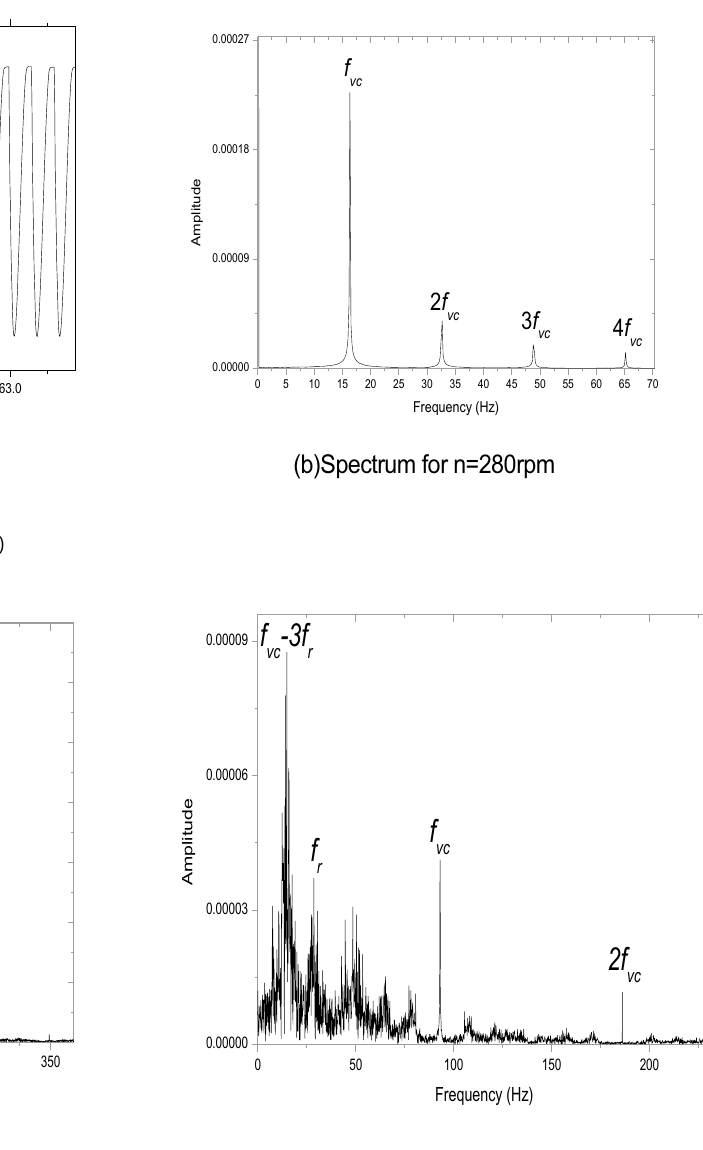
Fig. 7 Spectrum diagram (n = 1200 rpm) Fig. 8 Spectrum diagram (n = 1600